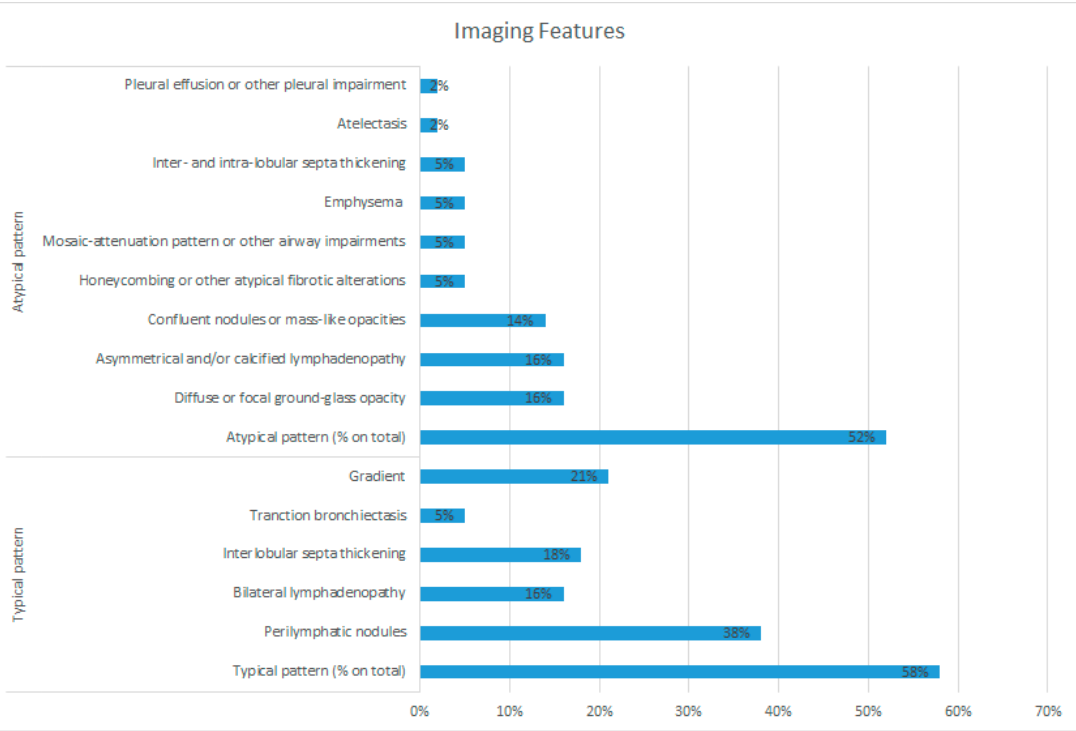
Figure 6. Proportion of imaging features.